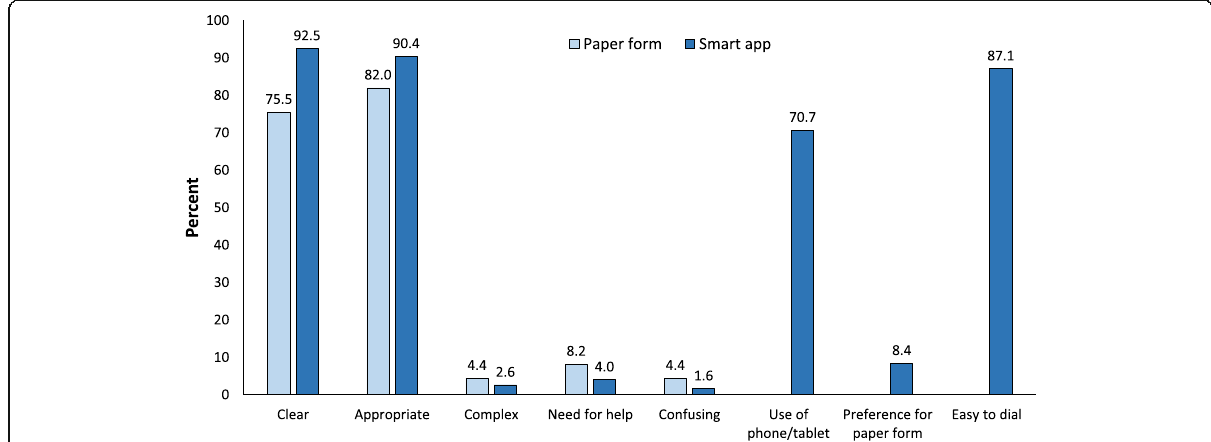
Fig. 4 Results of acceptability questionnaires for the ID-EC paper and smart app questionnaires. Proportions refer to affirmative